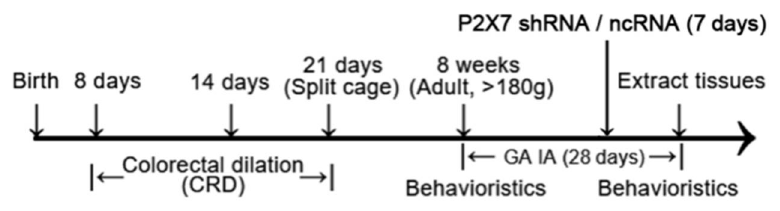
Figure 11. The flow chart showing the experimental design.